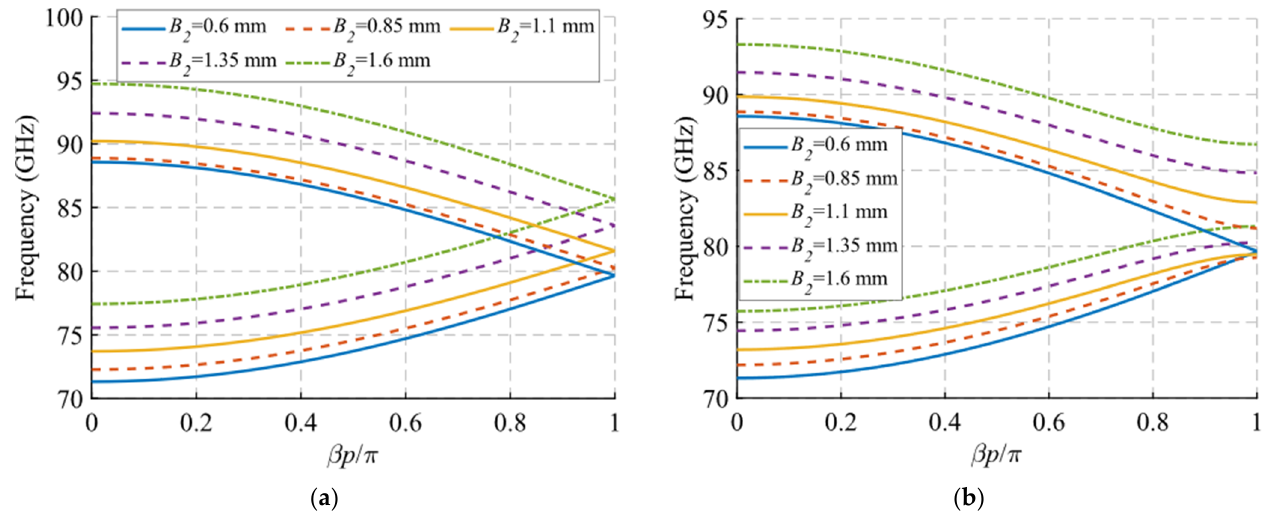
Figure 13. Dispersion diagram of the single-periodic unit cell for various values of B 2 . ( a ) Glide- symmetric configuration ( d = 0.725 mm) and ( b ) maximum rupture of symmetry configuration ( d = 0 mm).